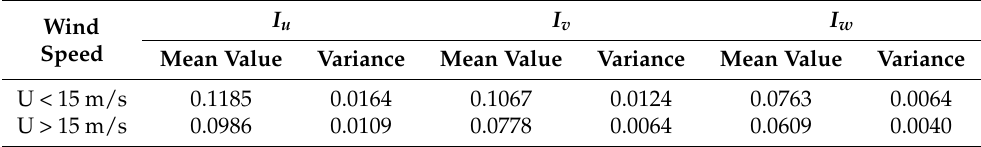
Table 4. Statistic value of the wind turbulence intensity (80 m).